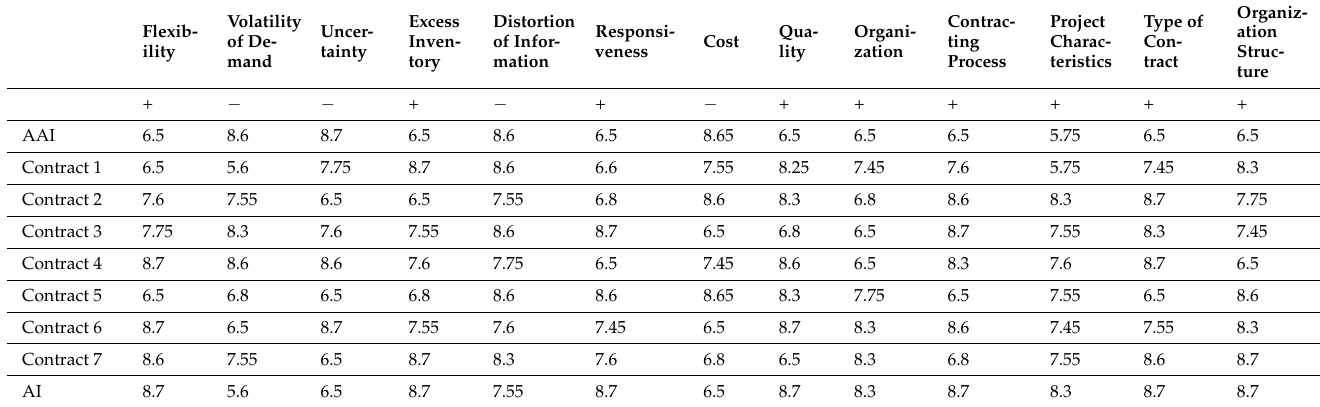
Table 12. Crisp decision matrix. + represents benefit criteria and – demonstrates cost criteria.